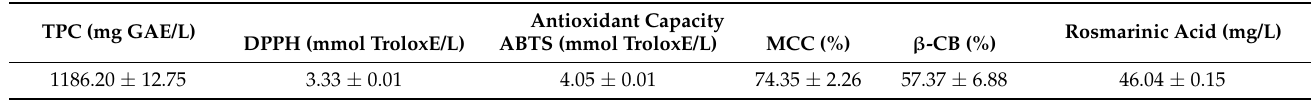
Table 1. Bioactive characterization of ground ivy extract.